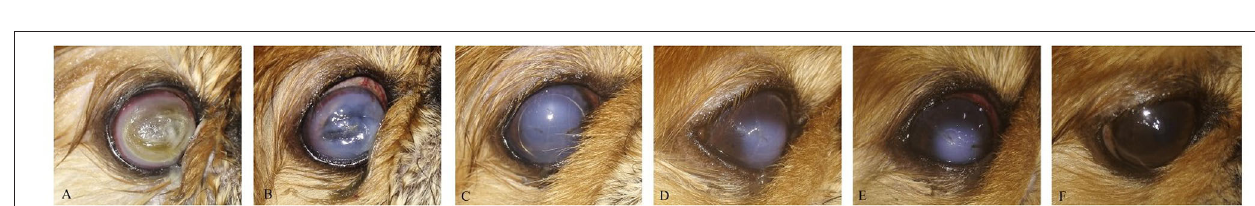
FIGURE 7 | A photography series of Rottweiler dog showing (A) deep ulcer with keratitis (B) reduction of ulcer size after 2-week post-injection (C) complete healing of ulcer after 3 months of injection.